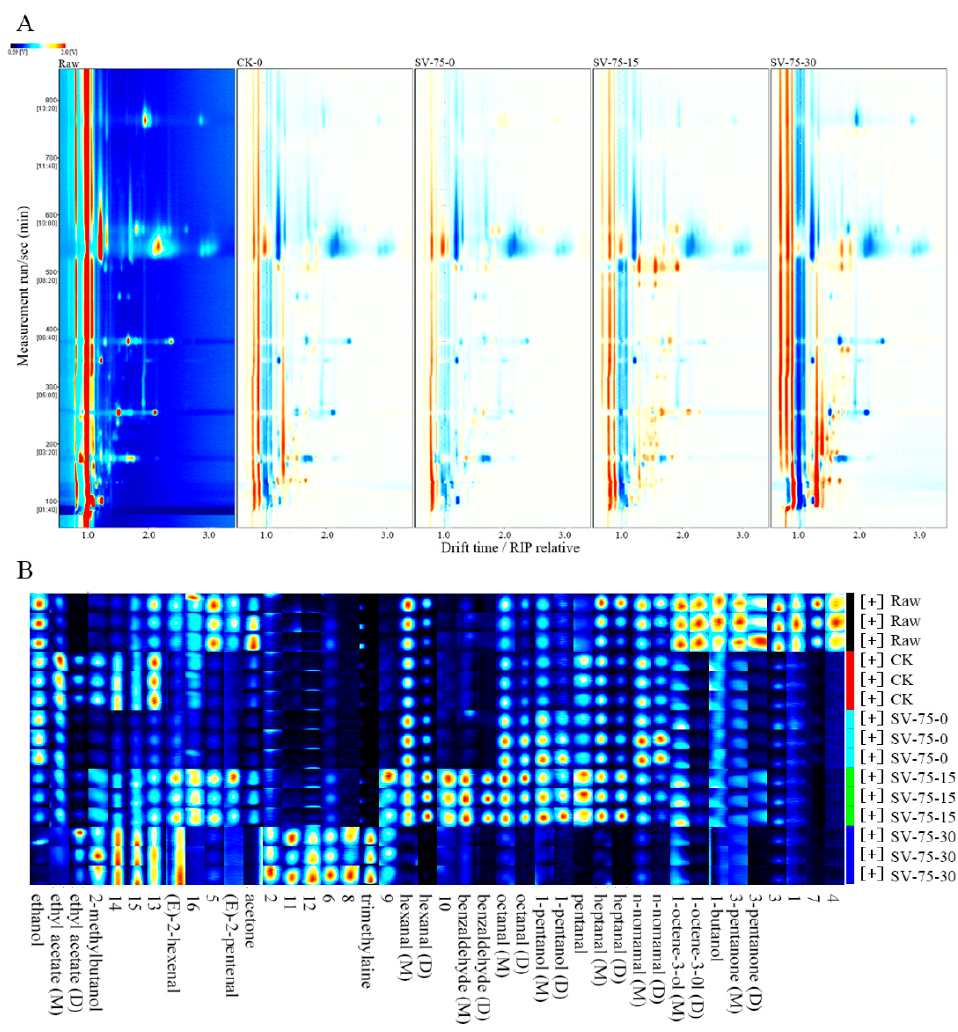
Figure 5. Two-dimensional spectrum ( A ) and fingerprinting plot ( B ) of volatile organic compounds in scallop muscle. Raw, fresh scallops; CK, scallop samples cooked at 100 °C for 10 min and stored for 0 d; SV-75-0, SV-75-15, and SV-75-30, scallop samples cooked at 75 °C for 30 min and stored for 0, 15, and 30 d, respectively.